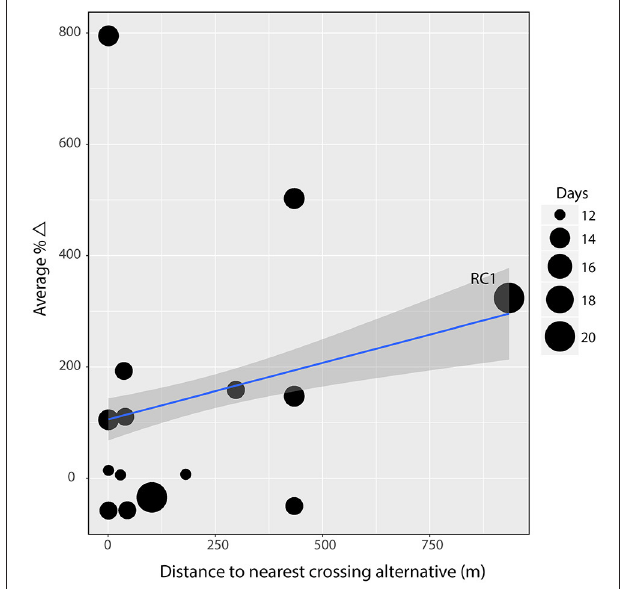
FIGURE 4 | Linear regression on weighted average percent difference in performance against the distance an animal must travel away from the crossing structure at the site to access the nearest alternative crossing opportunity. There is no evidence ( β = 0.08, R 2 = 0.004, p = 0.17) that the distance (in meters) an animal must travel to find an alternative crossing associates with performance. Gray band indicates 95% confidence interval and point size indicates number of days of observation at the site. The data point for site Ravalli Curve #1 (RC1) exhibited high leverage. When removed, the slope becomes significantly negative ( β = − 0.35, R 2 = 0.05, p = 0.001).